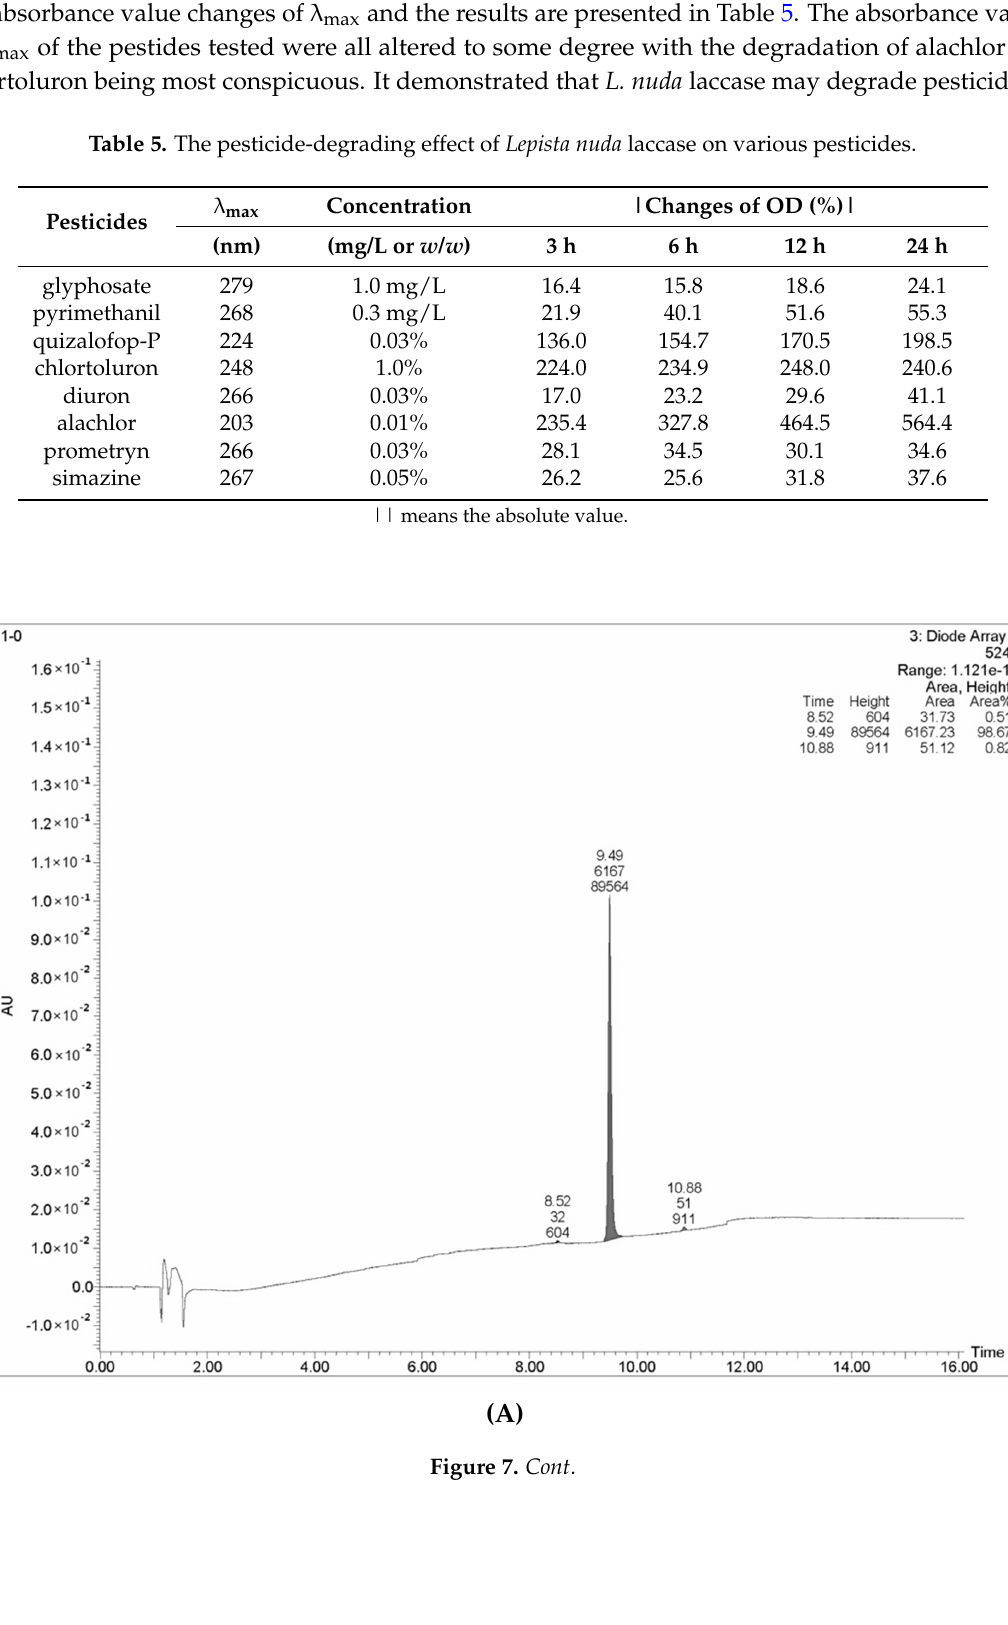
(B) Figure 7. The HPLC chromatogram of methyl red after decolorization by Lepista nuda laccase. ( A ) Methyl red control group ( B ) Methyl red which had been subjected to decolorization by the laccase for 48 h.